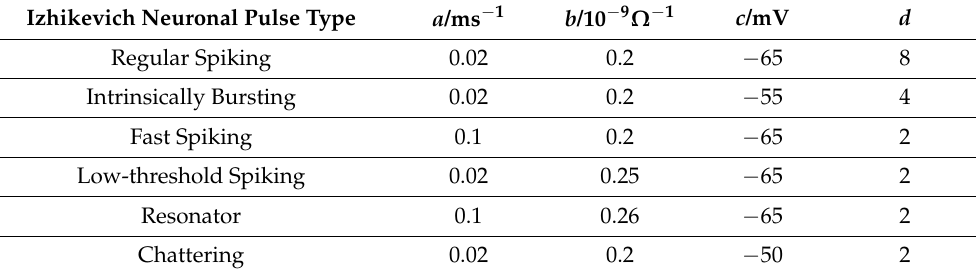
Table 1. Parameter tables of six typical Izhikevich